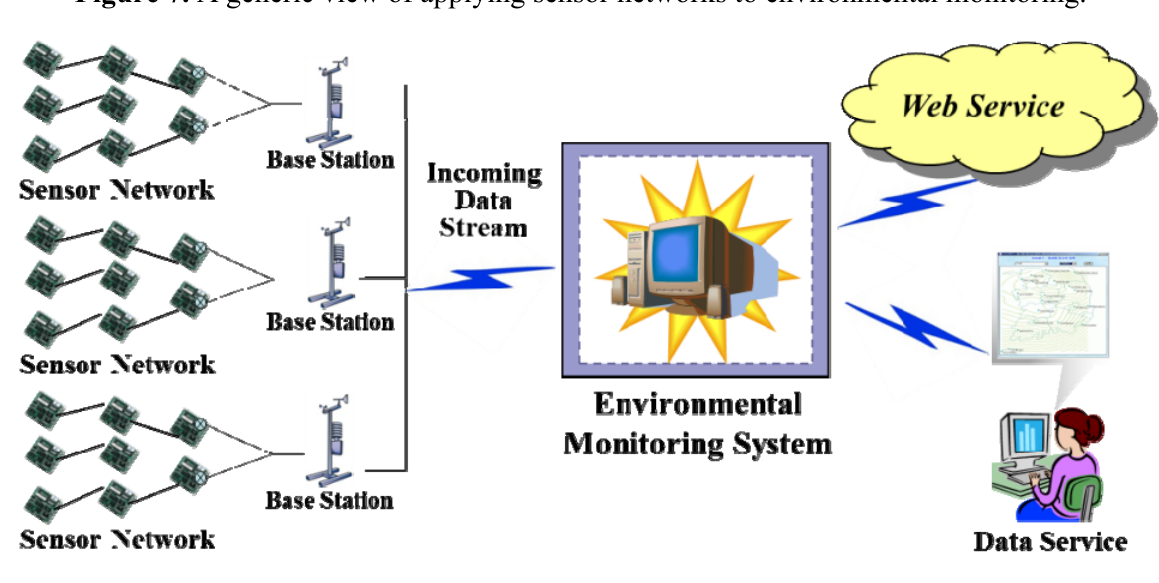
Figure 8. System architecture for environmental